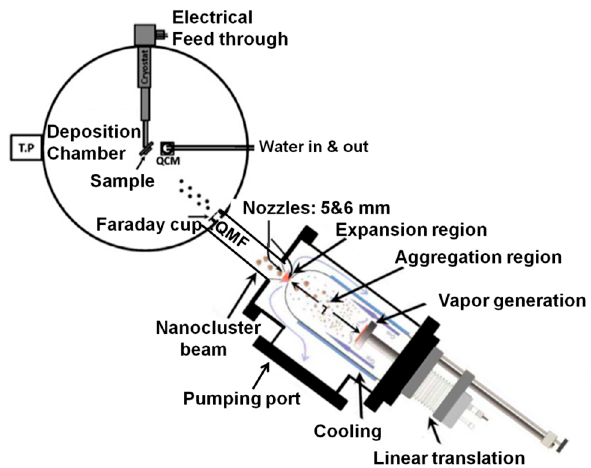
Figure 1. Schematic diagram of the deposition system, including the nanoparticle source and chamber deposition chamber [18] .